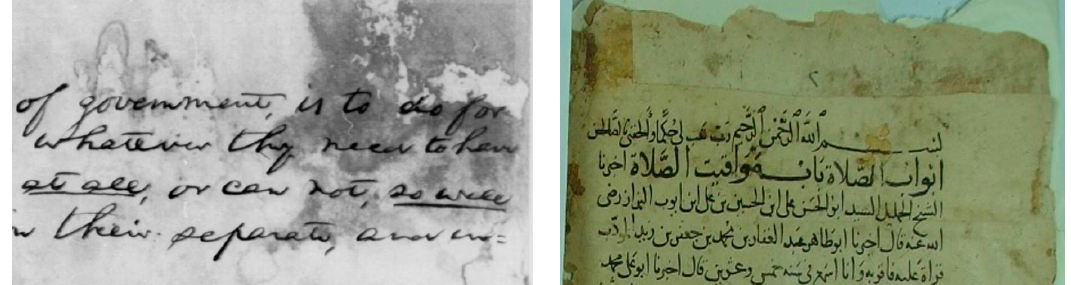
Figure 10. An example of deteriorated documents from DIBCO and Arabic databases.